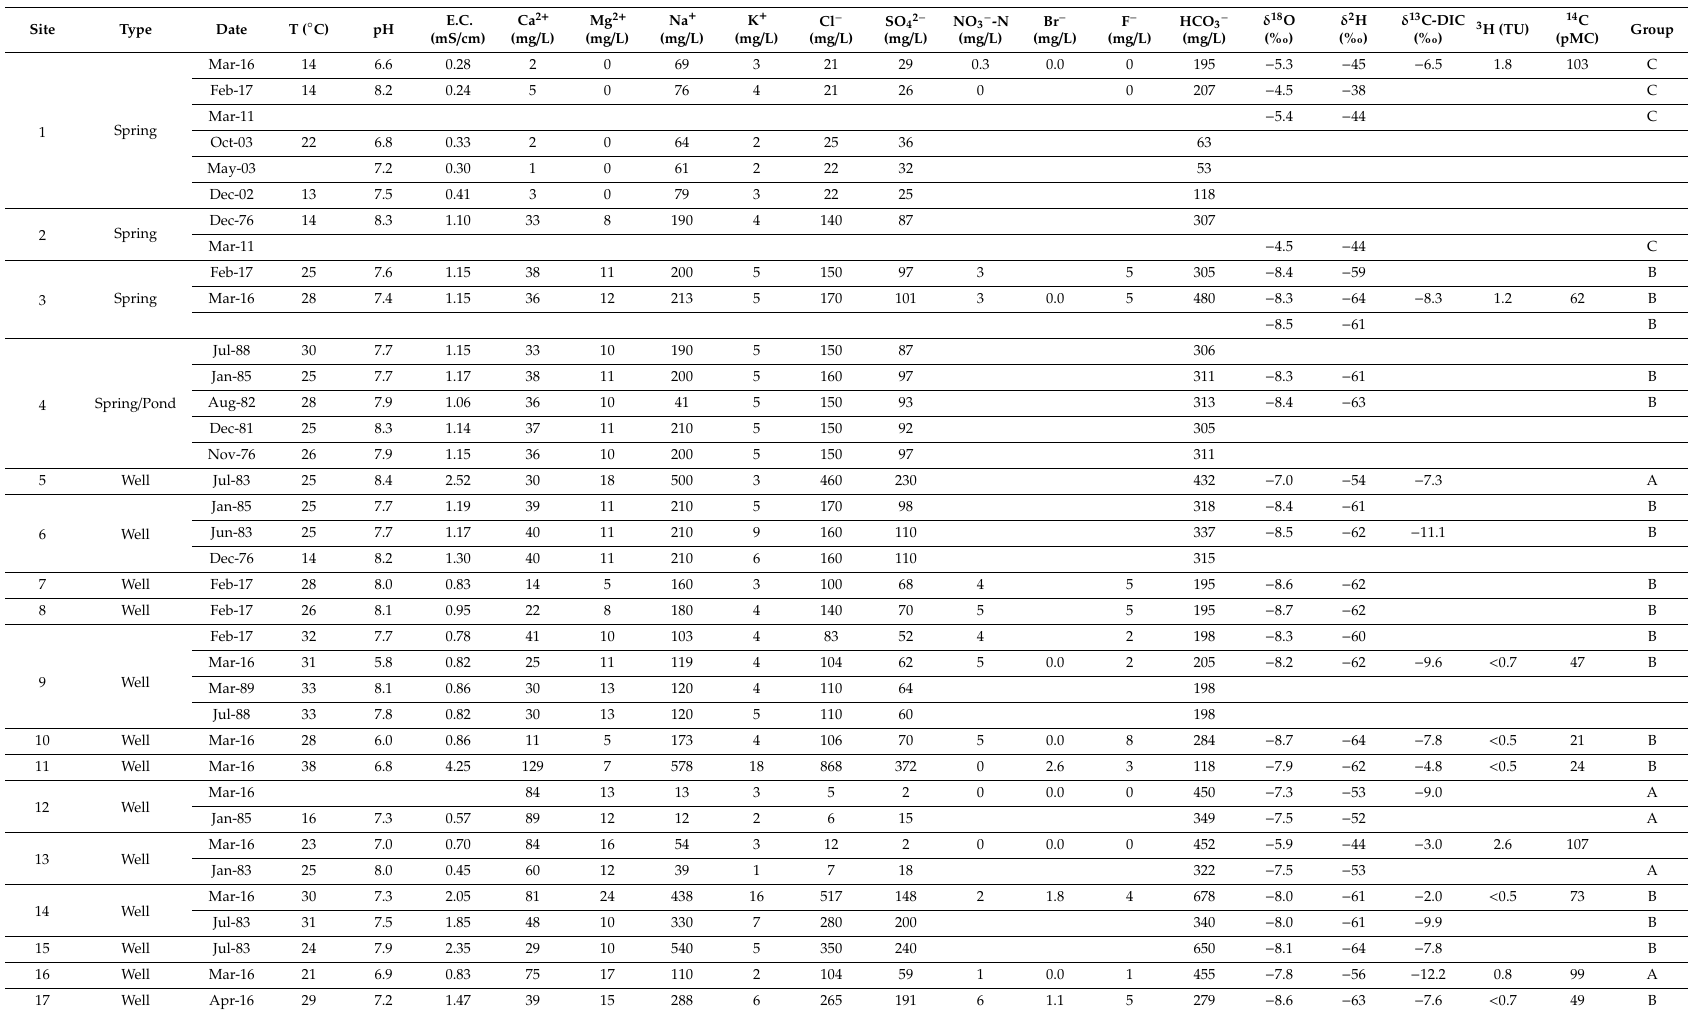
Table 1. Major ion chemistry and environmental isotope data of